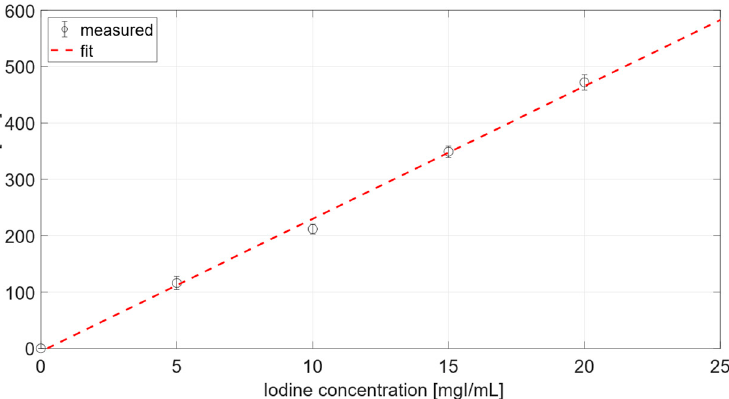
Figure 5. Calibration curve relating CT numbers and iodine concentration of CA4+ from CT reconstructions.